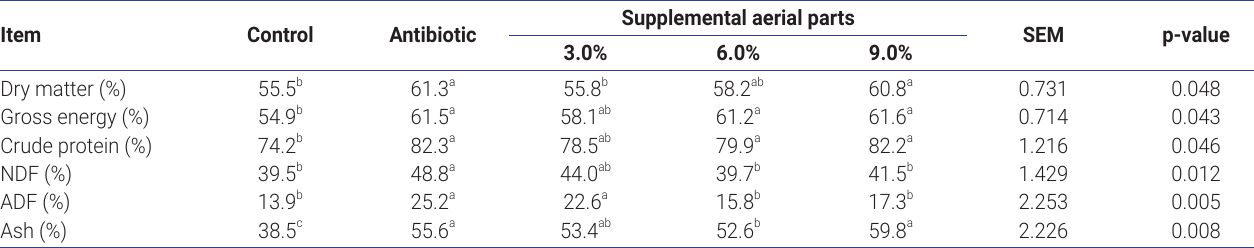
Table 4. Effect of Salvia miltiorrhiza aerial parts on the nutrient digestibility of rabbits